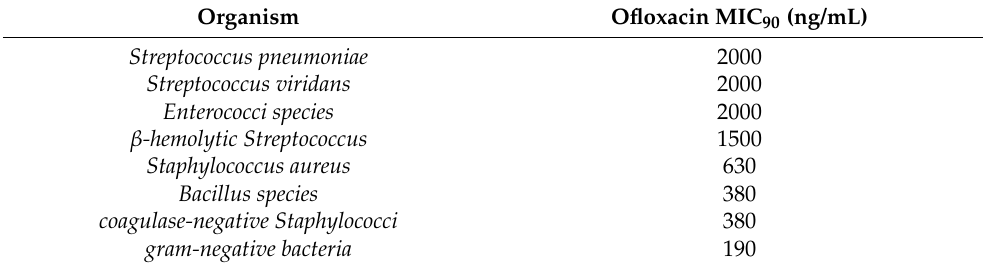
Table 1. Median minimum inhibitory concentrations (MIC 90 ) of ofloxacin in the AqH for common endophthalmitis pathogens